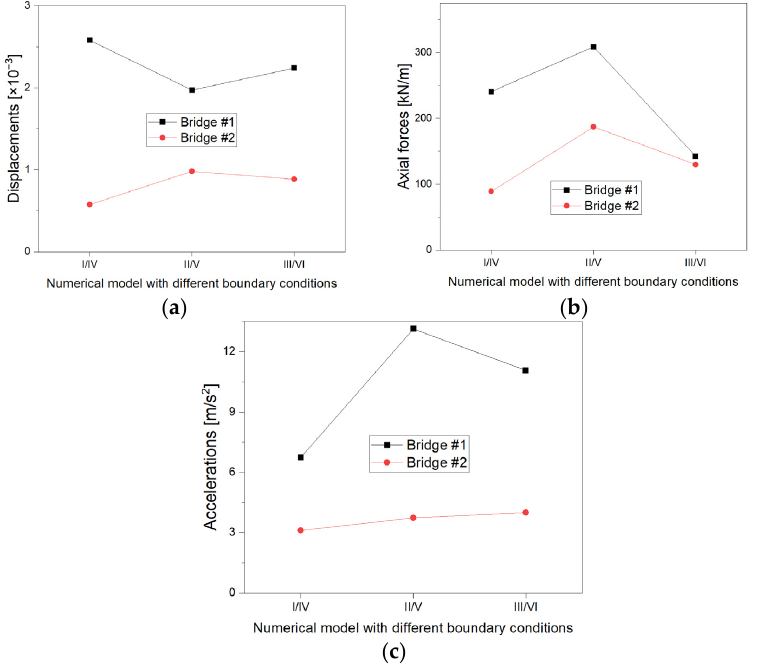
Figure 22. Comparison of displacements ( a ), axial forces ( b ), and accelerations ( c ) for bridge #I and